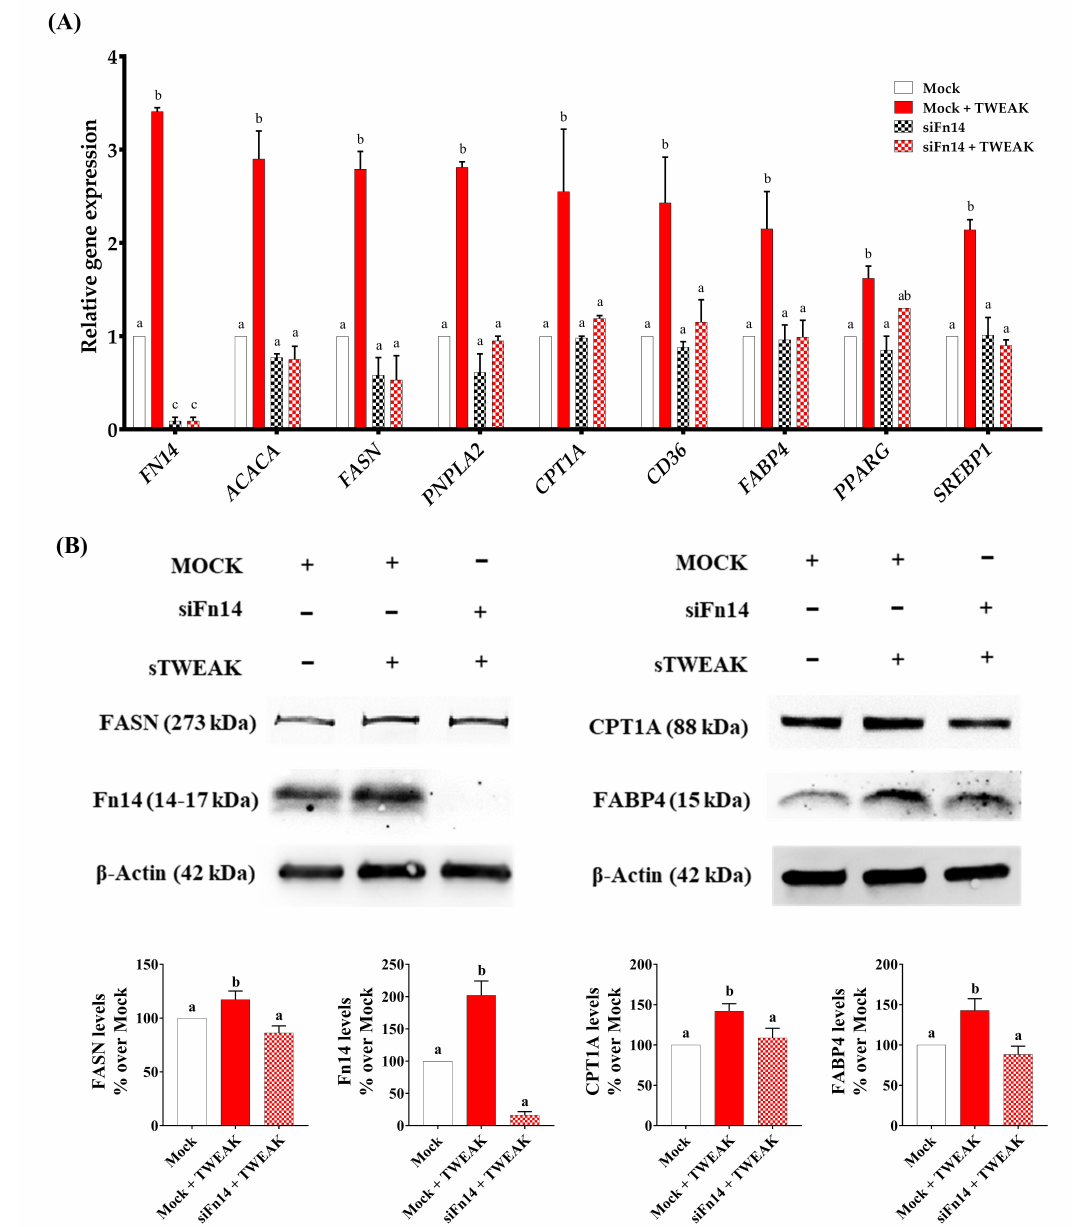
Figure 3. Inhibition of Fn14 in PC-3 cells blocks the sTWEAK-induced expression of lipid metabolism-related genes. ( A ) Fn14 was silenced in PC-3 cells using a Fn14 siRNA; a siRNA-negative sequence (MOCK) was used as a control. The cells were treated with 100 ng/mL TWEAK for 48 h, and the lipid-related gene expression was measured by RT-qPCR. ( B ) Protein expression in Fn14 siRNA/MOCK-transfected PC-3 cells of FASN, CPT1, Fn14 and FABP4 by Western blotting. Detailed information about the Western blotting can be found at Figure S3. Different lettering over the boxes indicates statistical differences. Significant differences are established at p < 0.05. Data are expressed as mean ± SEM ( n = 3 to 4 experiments). Abbreviations: Fn14, fibroblast growth factor-inducible 14; FASN, Fatty acid synthase; CPT1A, Carnitine palmitoyltransferase IA; siFn14, Fn14 small interfering RNA; FABP4, fatty acid-binding protein 4; ACACA, Acetyl-CoA Carboxylase Alpha; PNPLA2, patatin-like phospholipase 2; CD36, cluster of differentiation 36; PPARG, Peroxisome proliferator-activated receptor gamma; SREBP1, Sterol regulatory element-binding transcription factor 1; RT-qPCR, reverse transcription quantitative